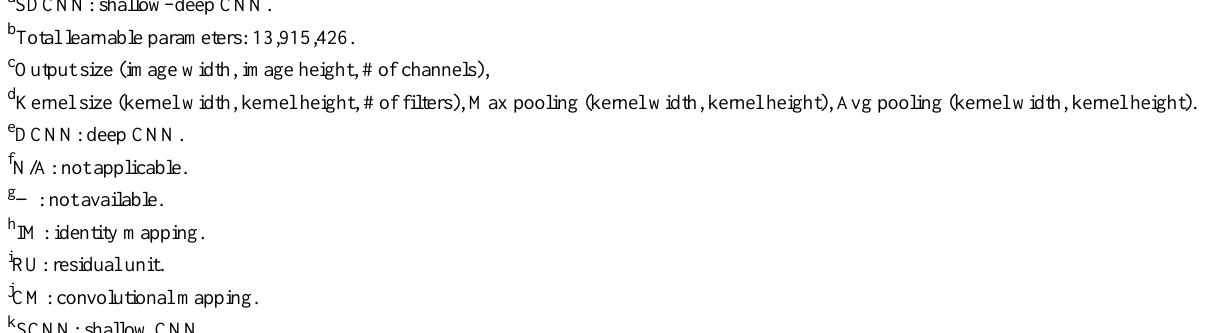
ParametersIterationsFilter size d Output size c Layer